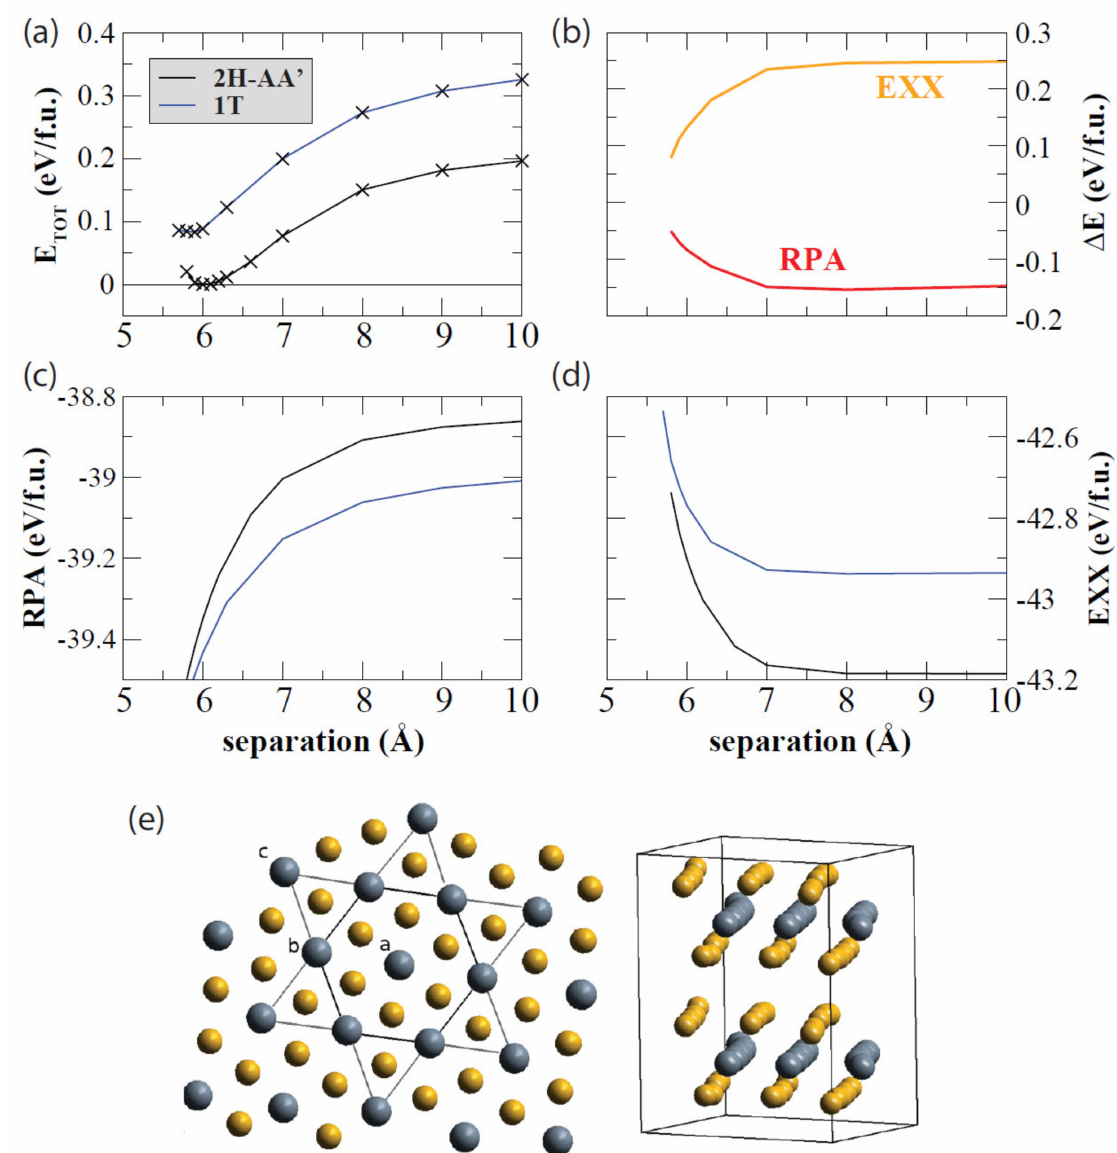
Figure 6. Decomposition of the total energy as a function of the separation of the S-Ta-S layers for the 1 T and 2 H polytypes is shown and plotted as such: ( a ) the total energy, ( b ) the RPA correlation energy, ( c ) the difference in the polytypes’ exact-exchange (EXX), and RPA energies ( d ) EXX. ( e ) The starlike arrangement of the atoms in the C-CDW phase from the in-plane view ( left ) and from the side view ( right ). Reprinted figure with permission from Reference [114]. Copyright 2015 by the American Physical